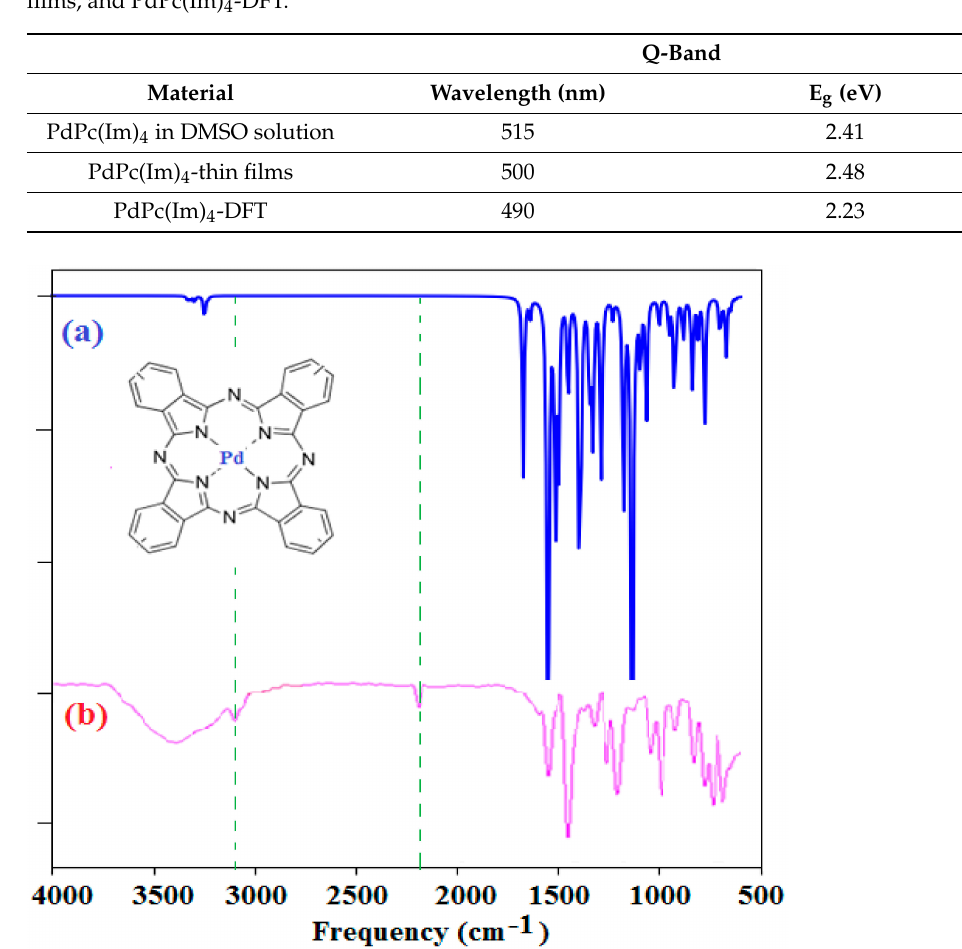
Figure 9. ( a ) Theoretical and ( b ) experimental infrared